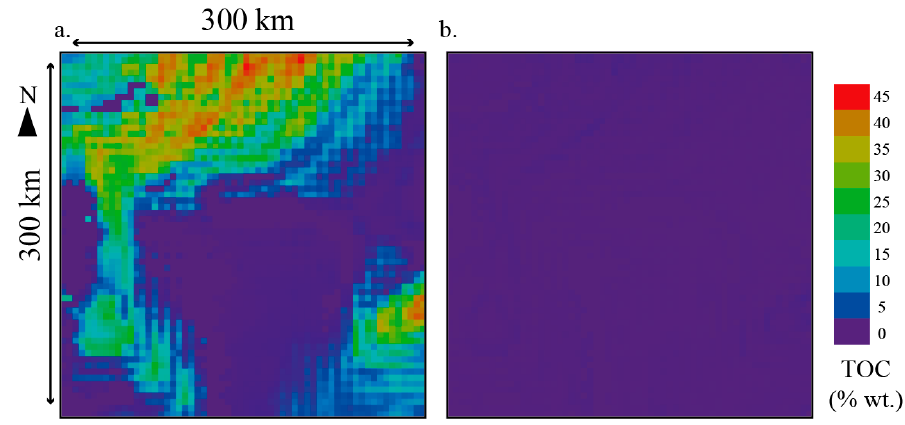
Figure 9. Maps of maximum ( a ) and minimum ( b ) TOC values provided by the meta-models for an interval comprised between 181.7 and 181.5 Ma.